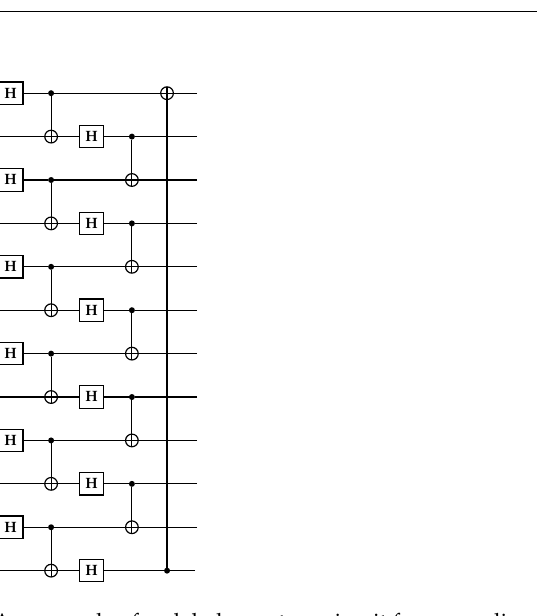
Figure 9. An example of a global quantum circuit for a one-dimensional PQCA.